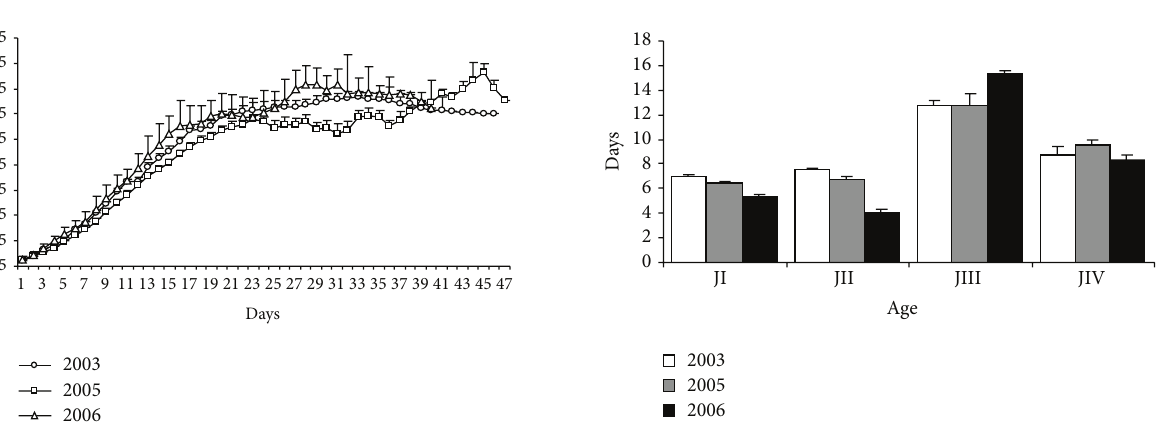
Figure 15: Mean time and days necessary for Sterna hirundinacea chicks to reach ages I, II, III, and